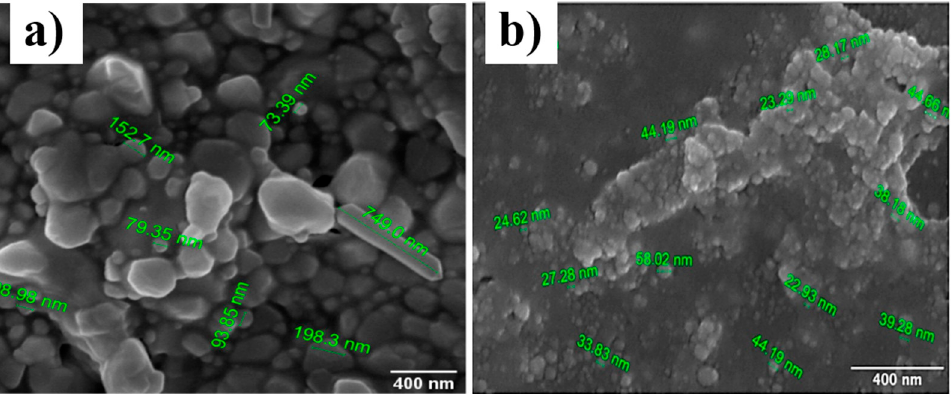
Figure 5. ( a ) FESEM image of silver nanoparticles synthesized using polyol method and ( b ) FESEM image of silver nanoparticles synthesized using cold method.